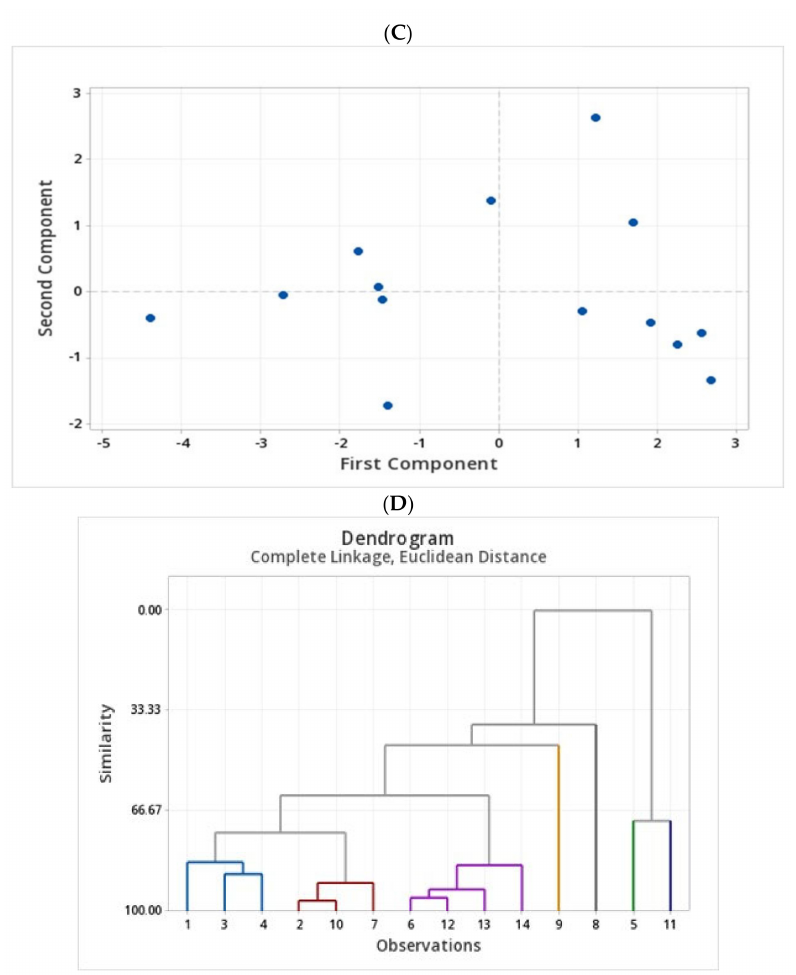
Figure 5. Principal component analysis and cluster analysis of the bound form of phenolic compounds in barley genotypes from Table 1; ( A , B ) the loading plot: blue dots indicate each barley genotype tested; ( C ) the scree plot of principal component analysis for FA, PCA, CAF, SIN, Iso FA, CAT, 4HBA, and VAN A; ( D ) dendrogram from cluster analysis for FA, PCA, CAF, SIN, Iso FA, CAT, 4HBA, and VAN A of 14 barley genotypes. Observations left to right in order: 1 = AAC Synergy, 3 = AC Metcalfe, 4 = CDC Copeland, 2 = AAC Goldman, 10 = Line 1, 7 = CDC Mindon, 6 = CDC Bow, 12 = Line 3, 13 = Line 4, 14 = Line 5, 9 = Lowe, 8 = Harrington, 5 = CDC Bold, and 11 = Line